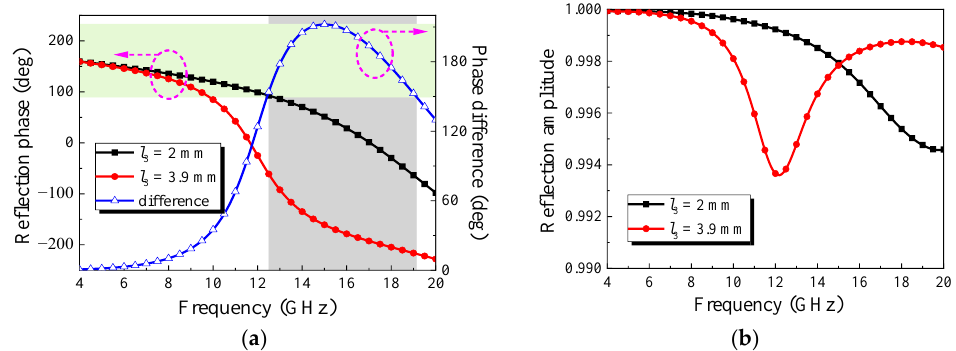
Figure 8. Simulation results of reflection performance: ( a ) reflection phase of the y -polarized incident wave; ( b ) reflection amplitude of the y -polarized incident wave.